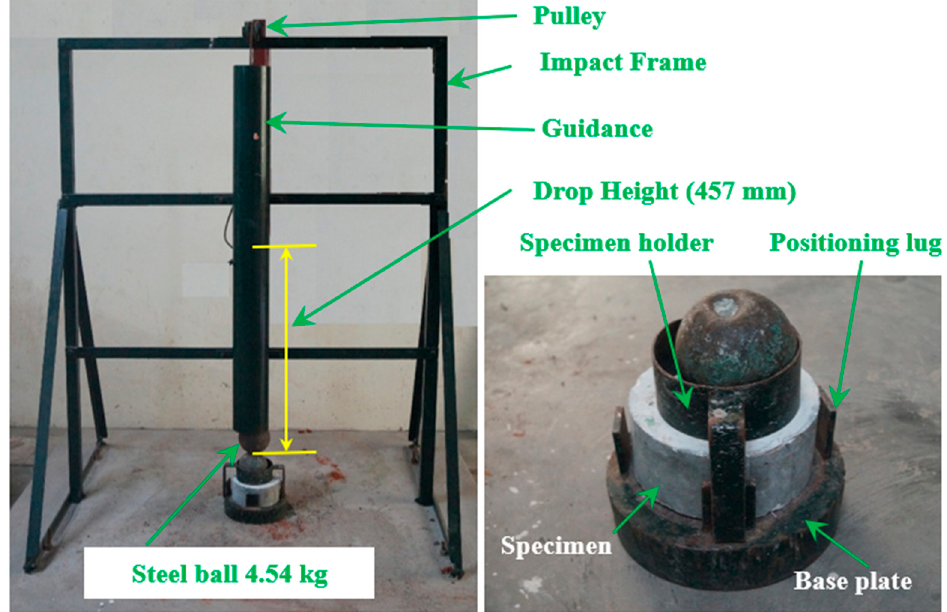
Figure 5. Impact test